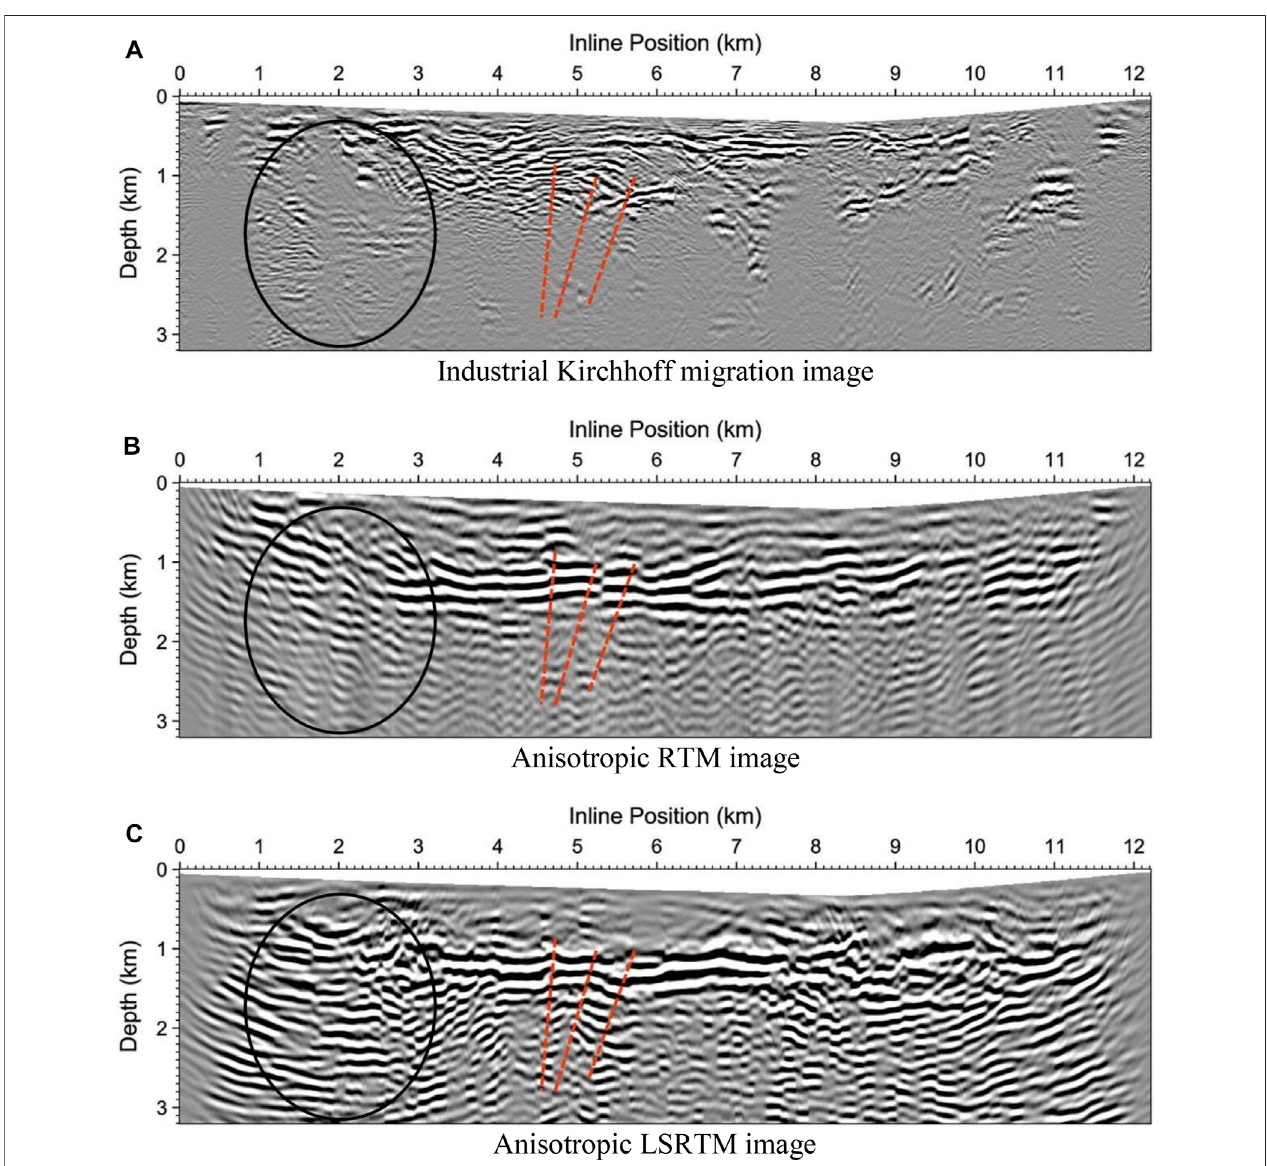
FIGURE 13 | Subsurface migration images of Line 4 at Eleven-Mile Canyon produced using various migration methods: (A) Industrial Kirchhoff migration, (B) AnisotropicRTM, (C) AnisotropicLSRTM. Theimagewithintheellipseregionin (C) correspondstotheruptureregionasshownin Figure1 .Theimageinthisregionhas higherresolutionthanthatin (B) ,andisalmostinvisiblein (A) .Thedelineatedfaultsin (C) maycorrespondtothefaultsidenti fi edintheU.S.GeologicalSurveyQuaternary fault and fold database as shown in Figure 1 .